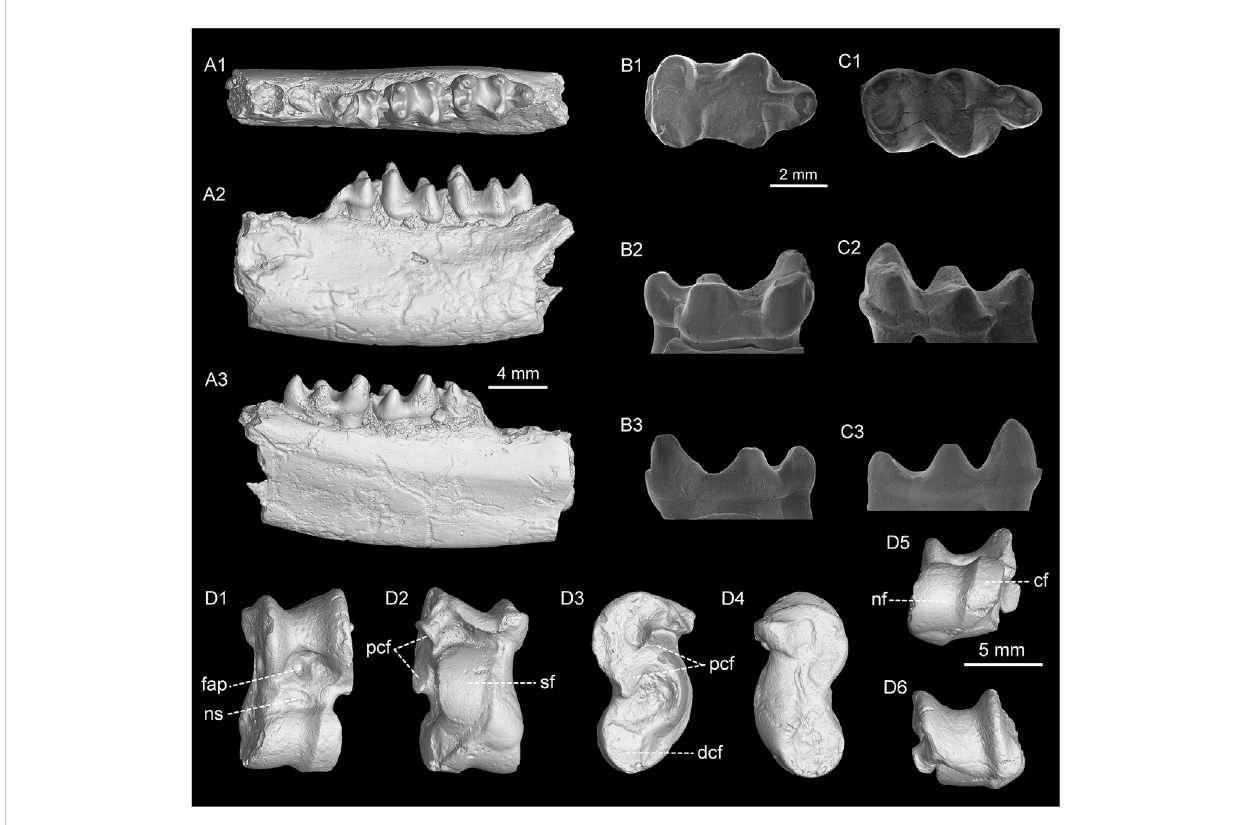
FIGURE 6 Lower jaw,astragalus, andisolatedm3of Obotherium aff. O. tongi . (A) leftlowerjaw with m1talonid and m2-3(IVPP V 31732.1); (B) right m3(IVPP V 31733); (C) leftm3 (V31734): (A1 – C1) ,occlusal view; (A2 – C2) ,buccalview; (A3 – C3) , lingual view; (D) leftastragalus(IVPP V 31732.2) in (D1) anterior; (D2) posterior; (D3) lateral; (D4) medial; (D5) distal; and (D6) proximal views. Abbreviations: cf , cuboid facet; dcf , distal calcaneal facet; fap , fossa for anterior process of tibia; nf , navicular facet; ns , fossa serving as a navicular stop; pcf , proximal calcaneal facet; sf , sustentacular